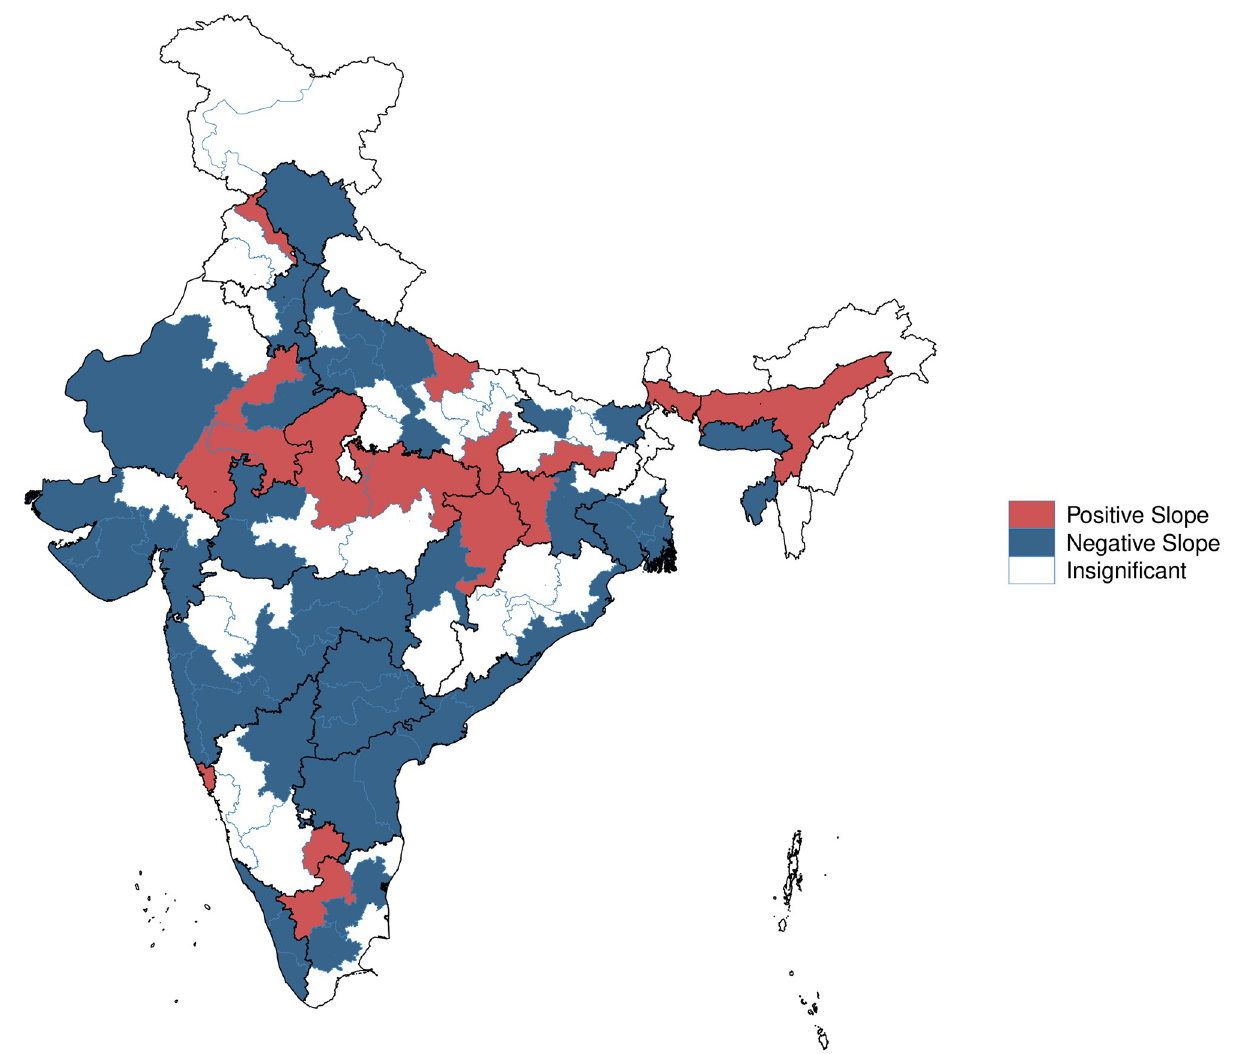
Fig 4. Variation in income and HR slope